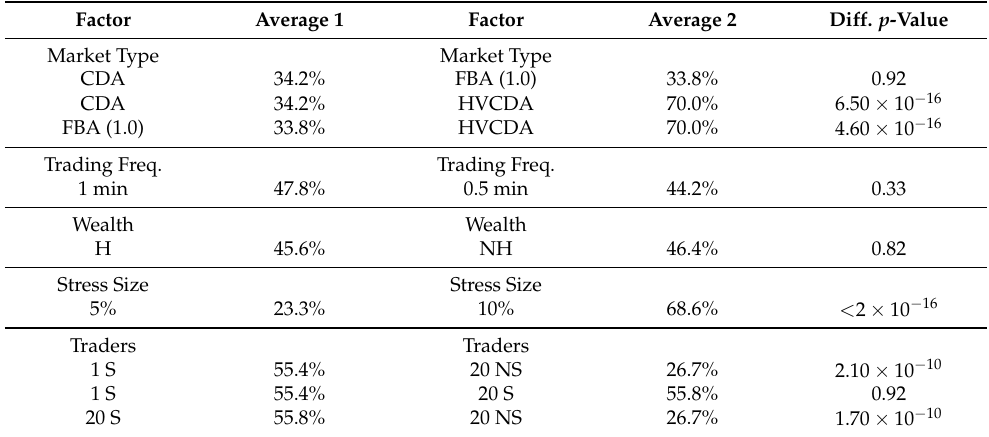
Table 10. Factors pairwise t -tests for determining which values increase the probability of immediate impact